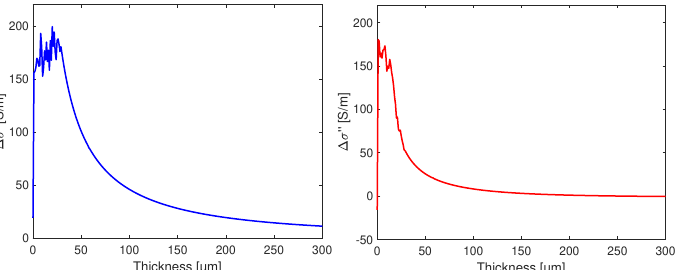
Figure 6. Extraction of the HR Si substrate photoconductance ∆ σ (left) Real part and (right) imaginary part according to the plasma depth t p of the HR Silicon illuminated by optical power Popt = 6 W at wavelength λ = 805 nm and F = 50 GHz.